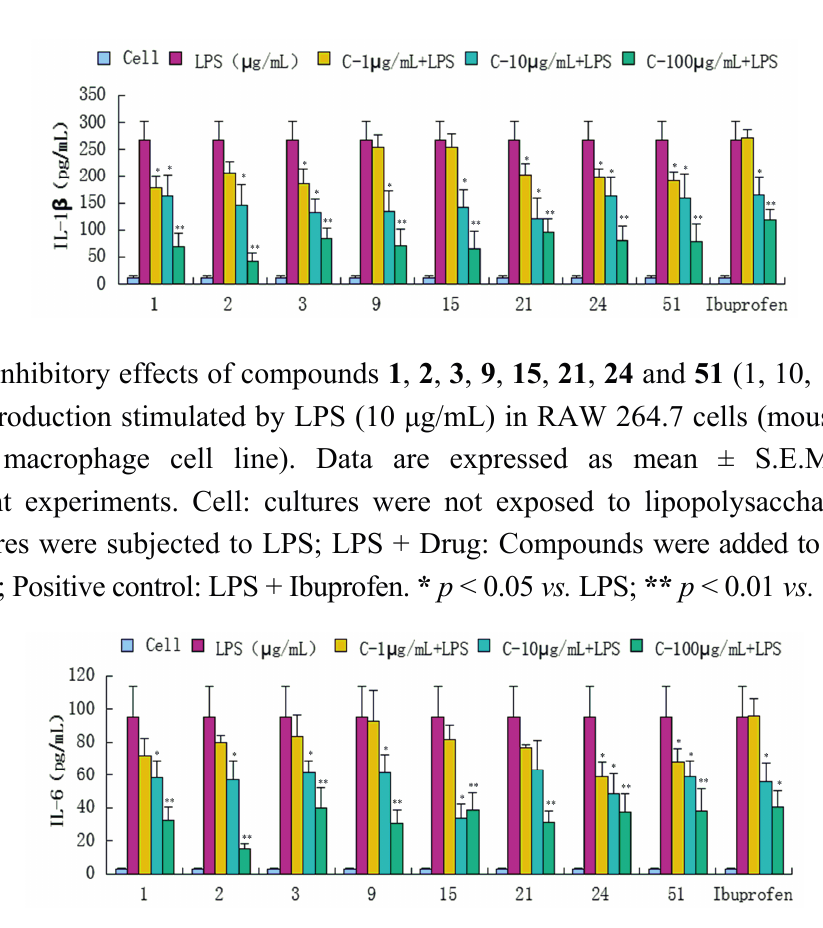
Figure 7. Inhibitory effects of compounds 1 , 2 , 3 , 9 , 15 , 21 , 24 and 51 (1, 10, 100 μ g/mL) on IL-6 production stimulated by LPS (10 μ g/mL) in RAW 264.7 cells (mouse leukemic monocyte macrophage cell line). Data are expressed as mean ± S.E.M. of three independent experiments. Cell: cultures were not exposed to lipopolysaccharide (LPS); LPS: cultures were subjected to LPS; LPS + Drug: Compounds were added to the cultures during LPS; Positive control: LPS + Ibuprofen. * p < 0.05 vs. LPS; ** p < 0.01 vs. LPS.